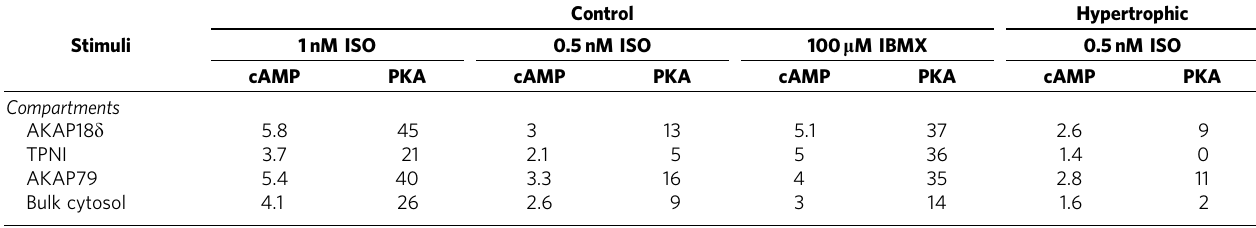
Concentration of cAMP ( m M) and increase in PKA activity over basal (expressed as percent of maximal activation) in untreated (control) and NE-treated (hypertrophic) NRVM at AKAP18 d , TPNI, AKAP79andin the bulkcytosol.cAMPconcentrations arecalculatedfromFRETchanges asmeasured withAKAP18 d -CUTie,TPNI-CUTie,AKAP79-CUTieor CUTieusingthe calibrationcurvesshownin Figs 1e and 2f. FRETchanges to calculate cAMPconcentrations are from Supplementary Fig. 4b,e and Fig. 6b,c. For completeness, data for cAMPchanges in the bulkcytosol in response to 1nM ISO and 100 m MIBMXarealsoshown.IncreaseinPKAactivityiscalculatedfromcAMPconcentrationsderivedasaboveusingthePKAactivitycalibrationcurveshowninSupplementaryFig.9.BasalPKAactivity is set at 3% based on the in-cell PKA activity calibration